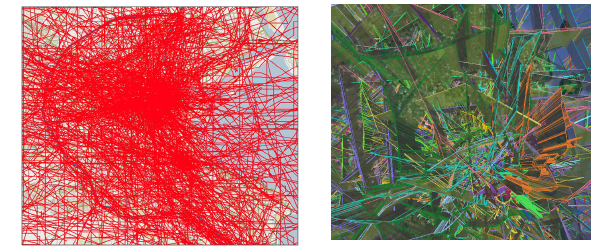
Figure 2: Trajectories in 2D Figure 3: Trajectories in